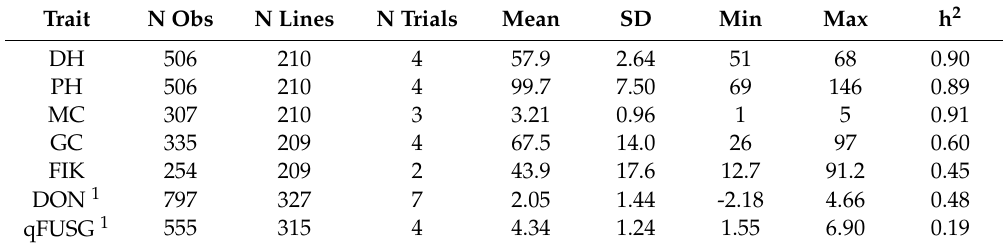
Table 1. Traits summarized are DH = Days to heading, PH = Plant height, MC = Maturity class (Maturity class 1 corresponded on average to 92 growing days, while class five to 101 days), GC = Germination capacity, FIKs = Fusarium -infected kernels, DON = deoxynivalenol content and qFUSG = relative amount of F. graminearum fungus DNA (pg) per oat DNA (100 ng). Total number of observations (n obs), number of unique lines (n lines), number of trials (n trials), mean, standard deviation (SD), min and max values are presented for each collected trait. The computed h 2 equals to the broad-sense heritability across trials according to Piepho and Möhring (2007) [110].